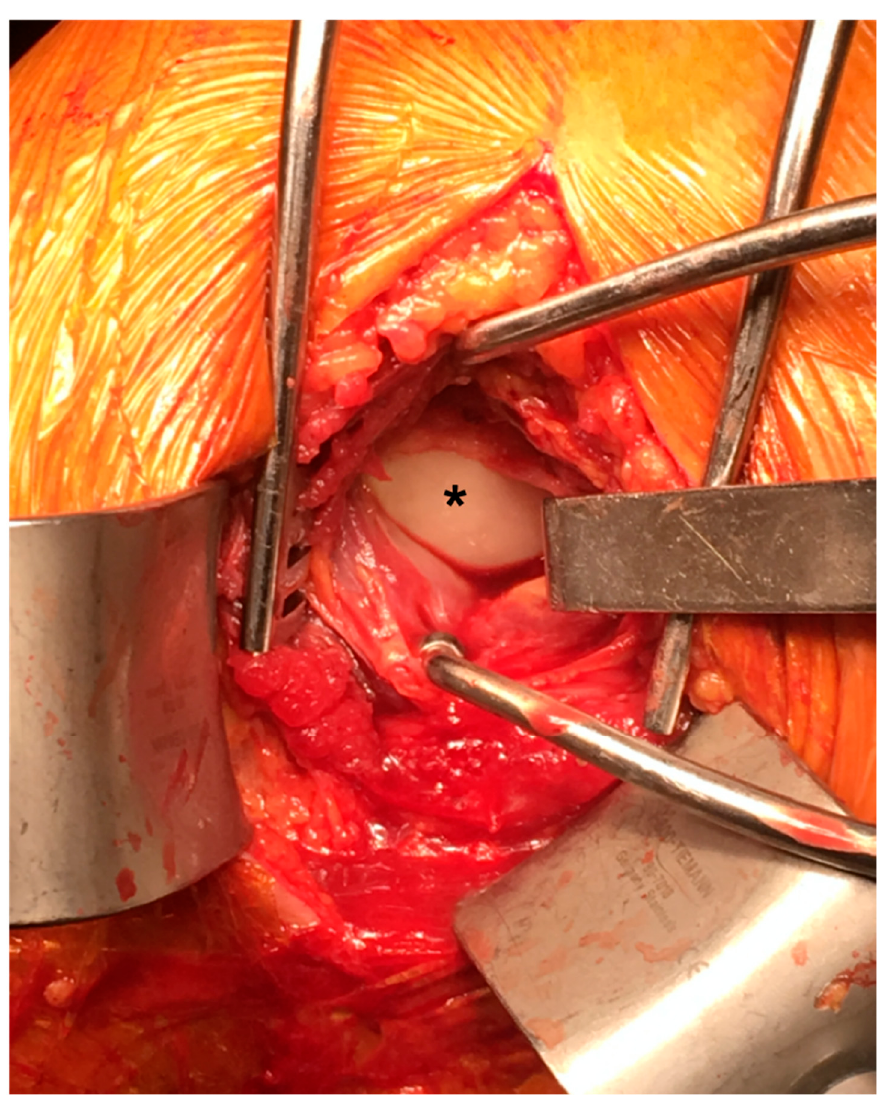
Figure 1. Left shoulder. Posterior Approach to the shoulder joint. The posterior capsule is injured, and the articular surface of the dislocated humeral head is facing posteriorly